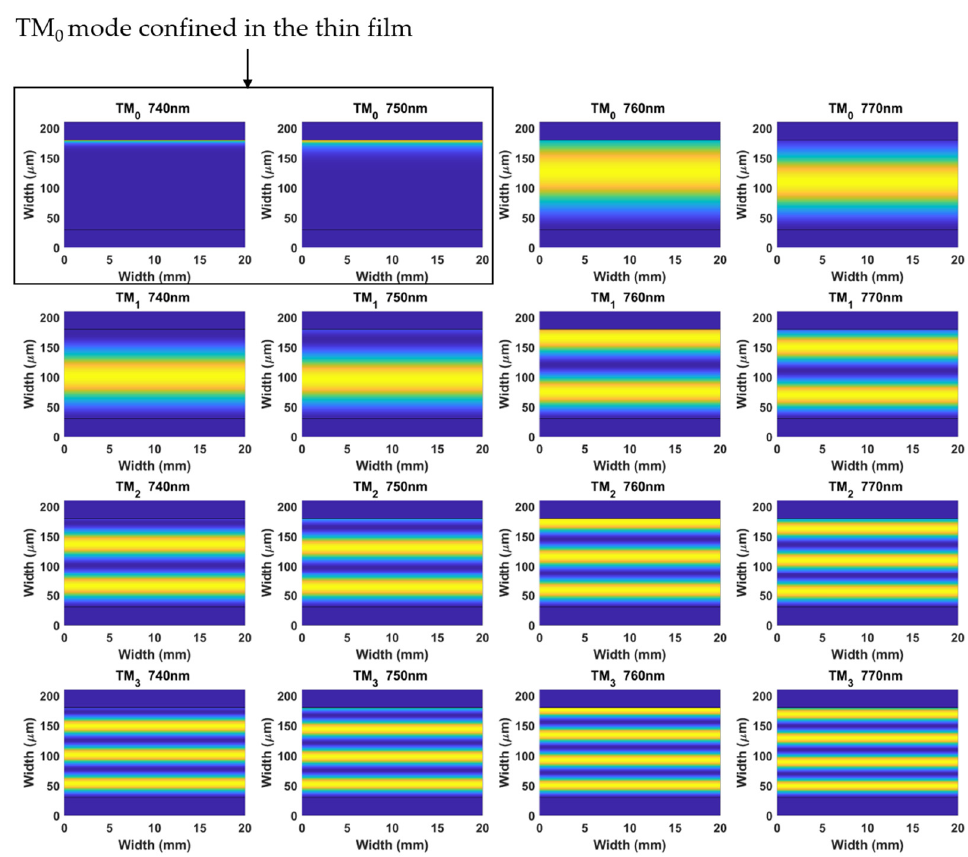
Figure 3. Optical field intensity distribution at the different wavelengths of TM 0 , TM 1 , TM 2 , and TM 3 , in the cross-section of the coverslip waveguide coated with a 70 nm TiO 2 thin film. Surrounding refractive index: 1.333 (water).